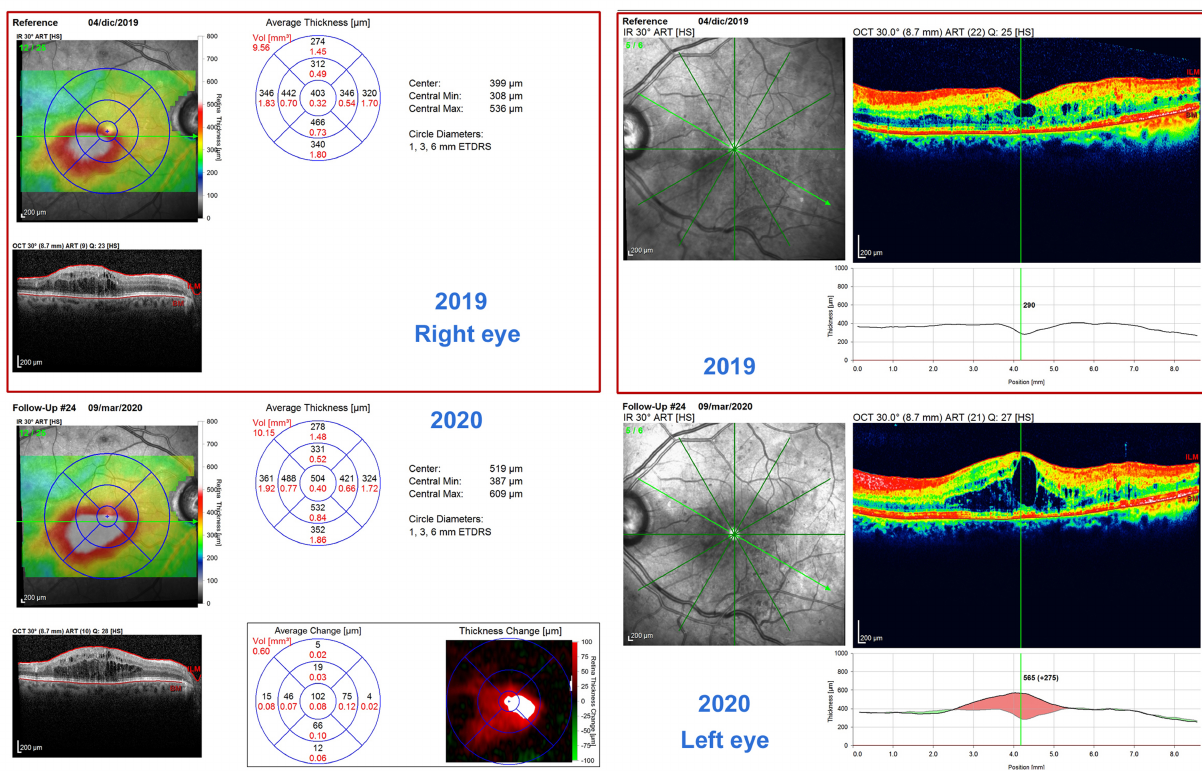
Figure 2. Spectral-domain optical coherence tomography (SD-OCT) of a diabetic patient right and left eye. The progression of the disease toward the stage of proliferative diabetic retinopathy (PDR) is defined by the development of persistent / chronic macular edema with flower petal cysts, important retinal and vitreous hemorrhages, marked fibrovascular proliferation, tractive retinal detachment, and, finally, vitreoretinal neovascularization with retinal detachment. SD-OCT